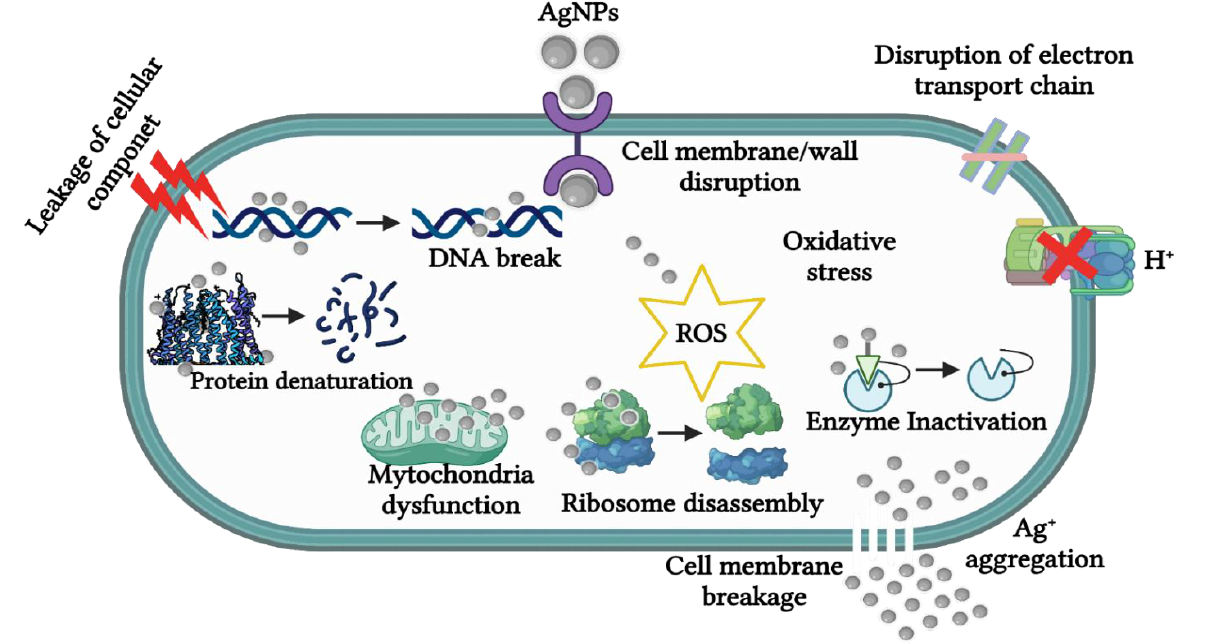
Figure 4. The anti-microbial action of AgNPs. The AgNPs can disrupt and penetrate the bacterial cell wall or membrane. The Ag + ions are then released into the bacterial cell and disrupt the functions of the cellular components and systems, leading to bacterial cell death.